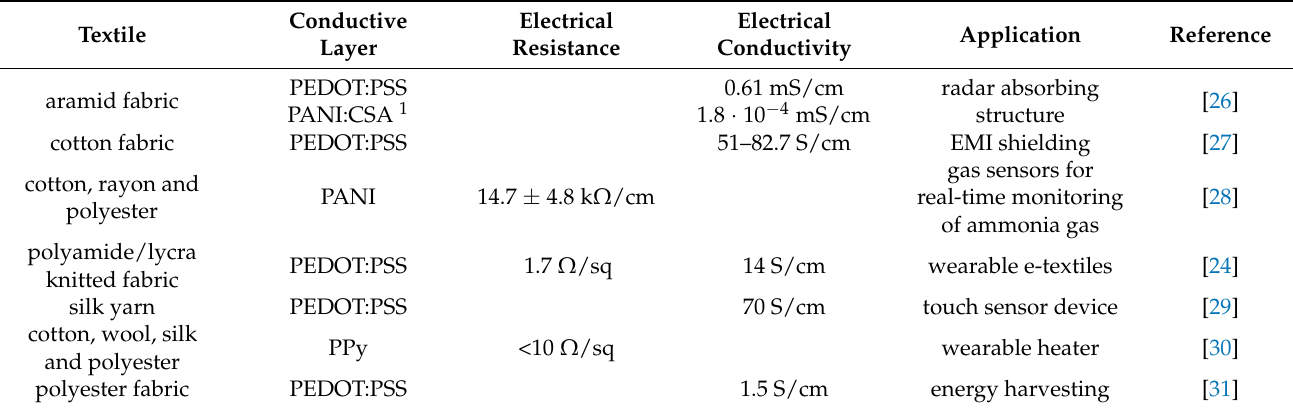
Table 2. Dip-coating of electro-conductive polymers on textiles for diverse